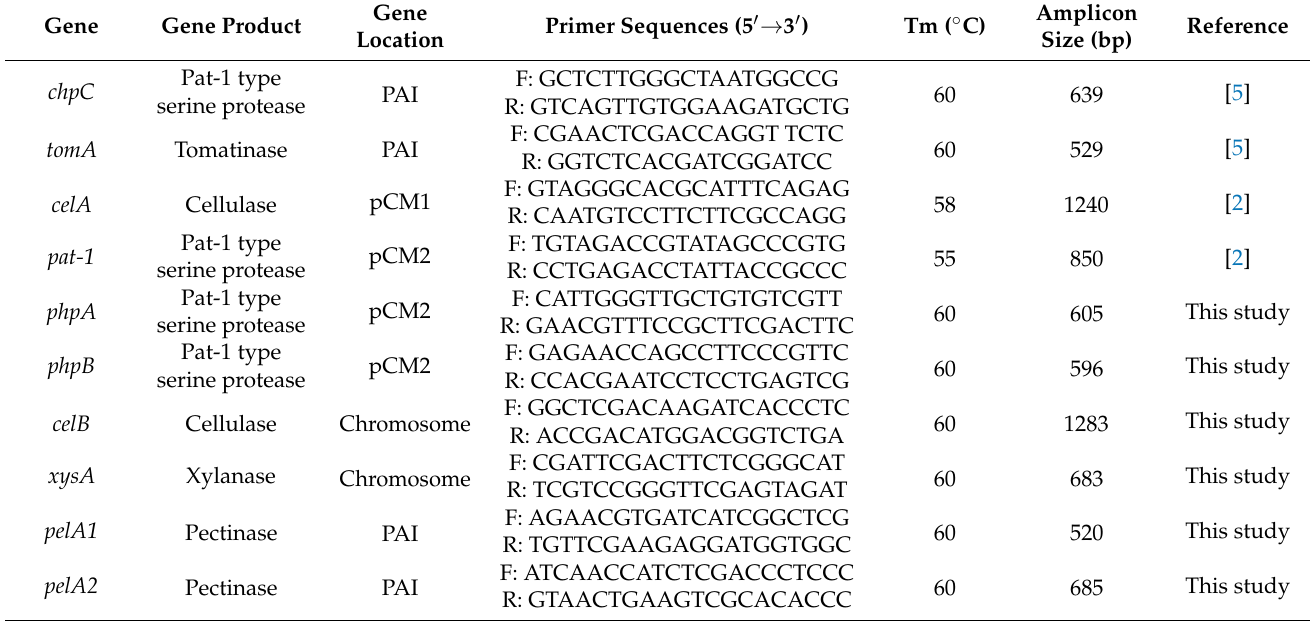
Table 2. Virulence genes of Clavibacter michiganensis subsp. michiganensis and primers used in this